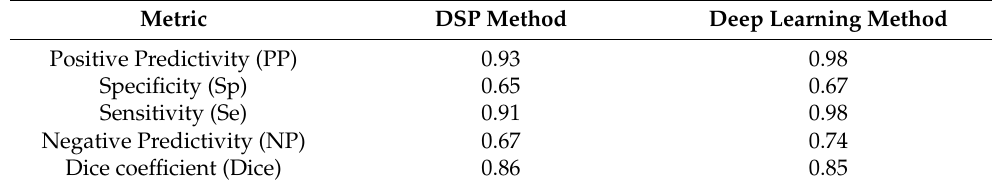
Table 1. Comparison of the evaluation metric calculated for both developed segmentation